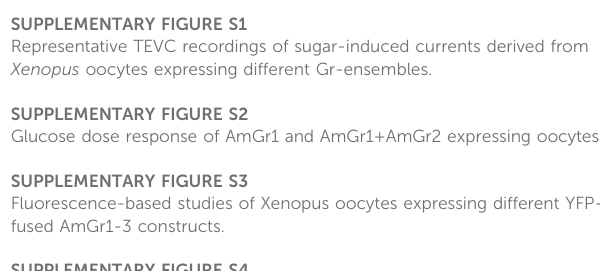
SUPPLEMENTARY FIGURE S1 Representative TEVC recordings of sugar-induced currents derived from Xenopus oocytes expressing different Gr-ensembles. SUPPLEMENTARY FIGURE S2 Glucose dose response of AmGr1 and AmGr1+AmGr2 expressing oocytes. SUPPLEMENTARY FIGURE S3 Fluorescence-based studies of Xenopus oocytes expressing different YFP- fused AmGr1-3 constructs. SUPPLEMENTARY FIGURE S4 Behavioural PER test with AmGr1 mutants (ns/ns), half-mutated and half in- frame-mutated bees of AmGr1 (ns/if) and wildtype bees (wt/wt) with a 30% solution of several other sugars (glucose, sucrose, fructose, maltose, arabinose) and water. SUPPLEMENTARY FIGURE S5 Replicates of behavioural evaluation through proboscis extension response (PER, in vivo) according to the section B of each fi gure (Figures 1 – 3). SUPPLEMENTARY FIGURE S6 Overview of the receptors (AmGr1, AmGr2 and AmGr3) gene sequences and the early stop codons introduced by mutational